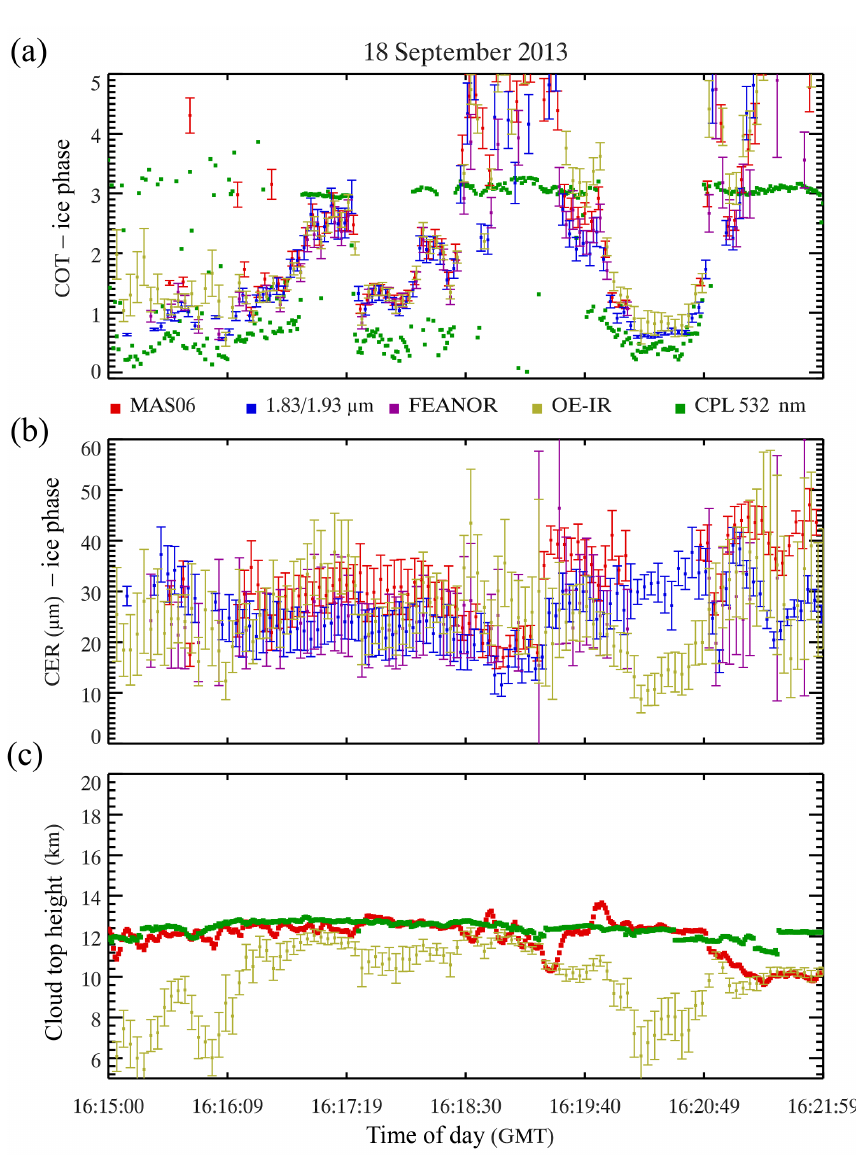
Figure 5. A comparison of nadir-view ice-phase COT (a) , CER (b) , and CTH (c) retrievals for the same track as in Fig. 6; the earliest-time retrievals correspond to the top of each panel in Fig. 6. Vertical bars indicate estimated retrieval uncertainties. The retrievals plotted here are from MAS06 (red), the 1.83/1.93µm approach (blue), FEANOR optimal estimation (magenta), and OE-IR (gold), as well as collocated CPL 532nm (green); note the MAS06 CER retrievals are those using the 2.1µm